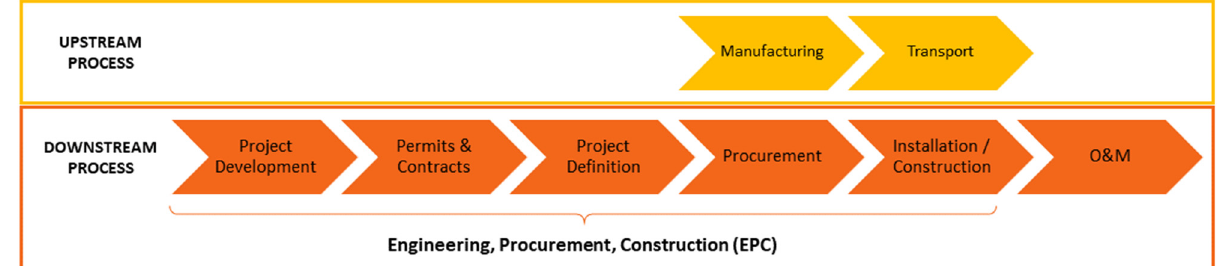
Fig. 1. Main stages of the current reference